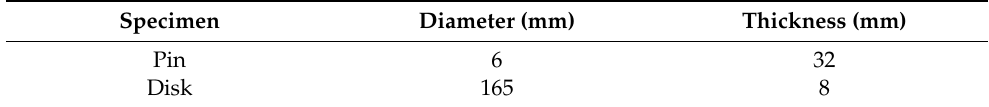
Table 1. Geometric parameters of PoD specimens.